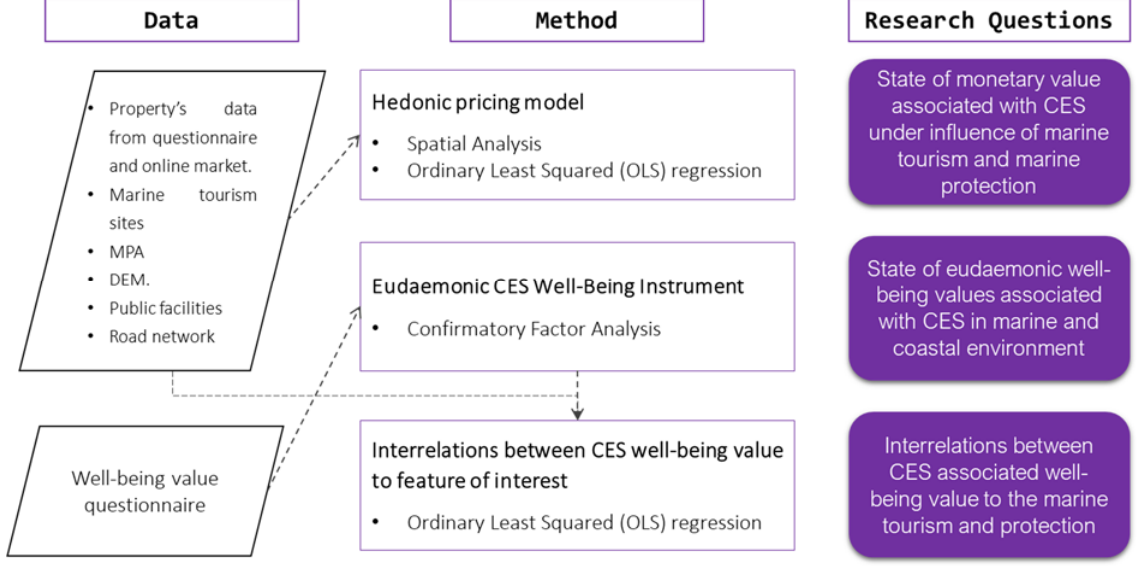
Figure 4. Methodology and data for respective research